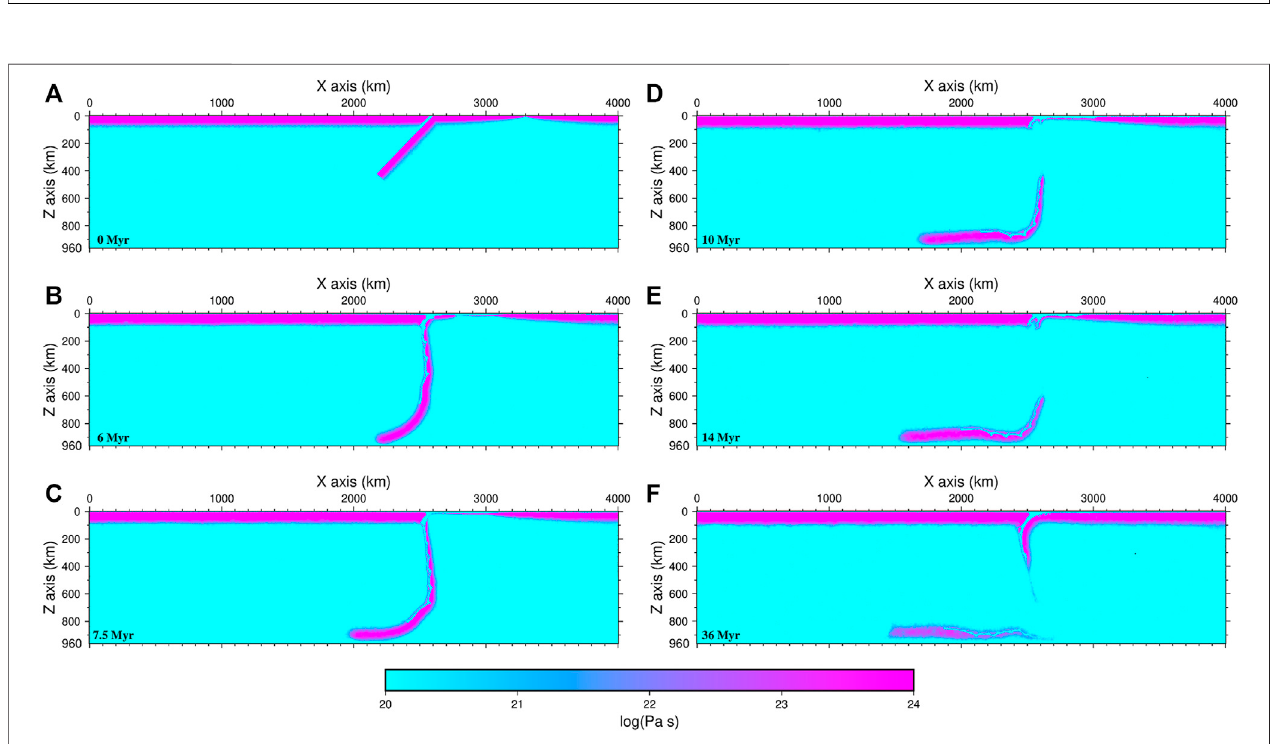
FIGURE 4 | The viscosity structure for case RS01 ( L (cid:1) 600 km, V x (cid:1) 3 cm/yr, θ (cid:1) 45 ° ) with the ViscT viscosity structure. (A – F) Snapshots at 0, 6, 7.5, 10, 14 and 36 Myrs.